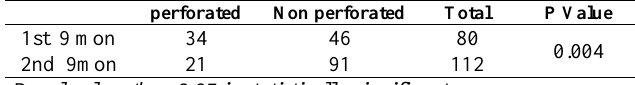
Table 3: Rate of perforation in related to experience of surgeons.